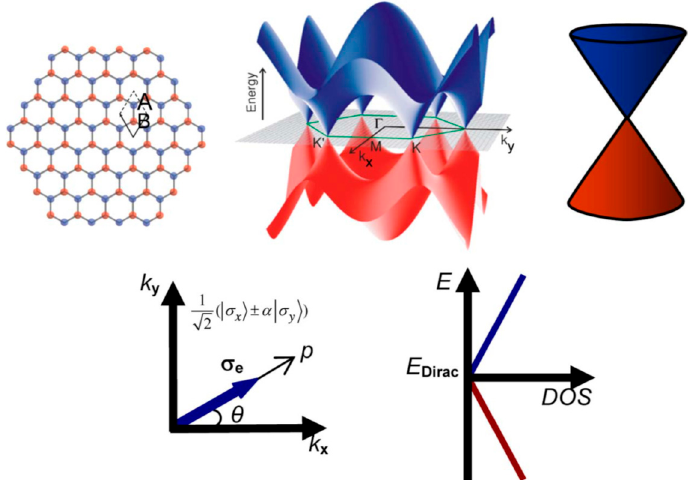
Figure 57. Left to right: Graphene lattice, electronic bandstructure, linear dispersion at low energies, pseudospin components, and density of states (DOS) dependence on energy [384].